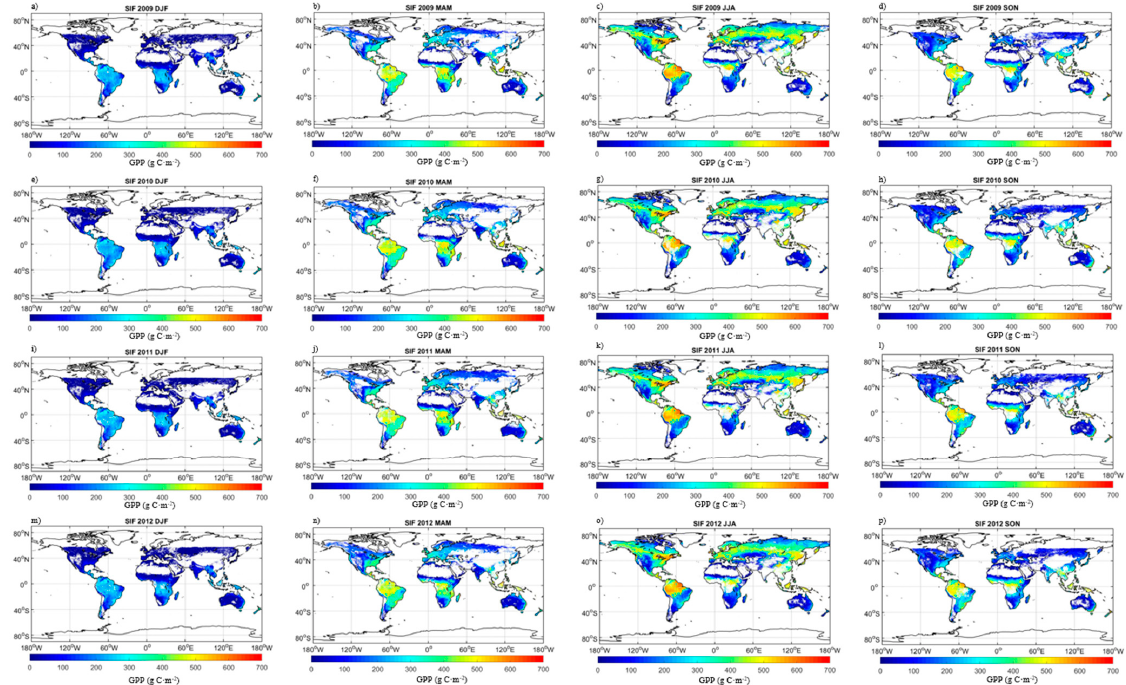
Figure A3. Spatial patterns of global GPP in different seasons: ( a ) GPP SIF in DJF of 2009; ( b ) GPP SIF in MAM of 2009; ( c ) GPP SIF in JJA of 2009; ( d ) GPP SIF in SON of 2009; ( e ) GPP SIF in DJF of 2010; ( f ) GPP SIF in MAM of 2010; ( g ) GPP SIF in JJA of 2010; ( h ) GPP SIF in SON of 2010; ( i ) GPP SIF in DJF of 2011; ( j ) GPP SIF in MAM of 2011; ( k ) GPP SIF in JJA of 2011; ( l ) GPP SIF in SON of 2011; ( m ) GPP SIF in DJF of 2012; ( n ) GPP SIF in MAM of 2012; ( o ) GPP SIF in JJA of 2012; ( p ) GPP SIF in SON of 2012.